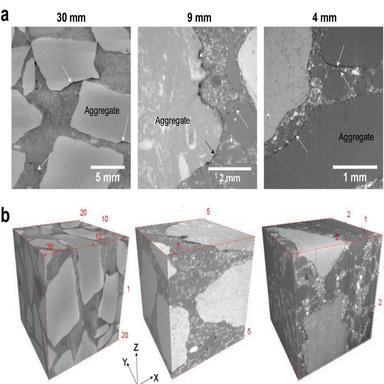
X-ray μCT images of C-DS cores of 30 mm, 9 mm and 4 mm diameter acquired with Xradia MicroXCT-400. a, Example 2D image slices showing detectable microcracks (marked by arrows). b, Corresponding 3D renderings. All dimensions in μm.